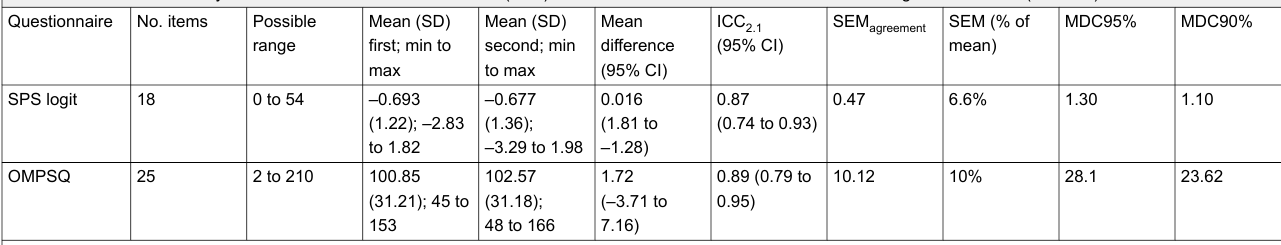
Table 2: Test-retest reliability results for the Situational Pain Scale (SPS) and the Örebro Musculoskeletal Pain Screening Questionnaire (OMPSQ). Questionnaire No.